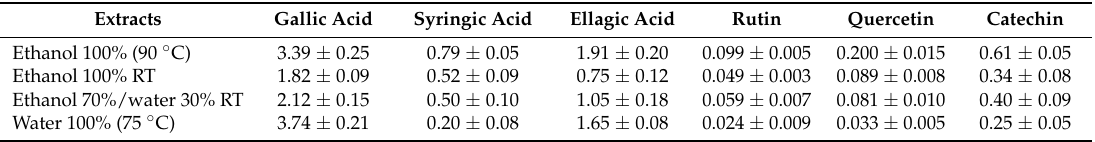
Table 1. Polyphenols in the chestnut shell extracts analyzed by HPLC/photodiode array detector (DAD) expressed as g/kg ± SD ( n = 6) of extract. RT: room temperature.